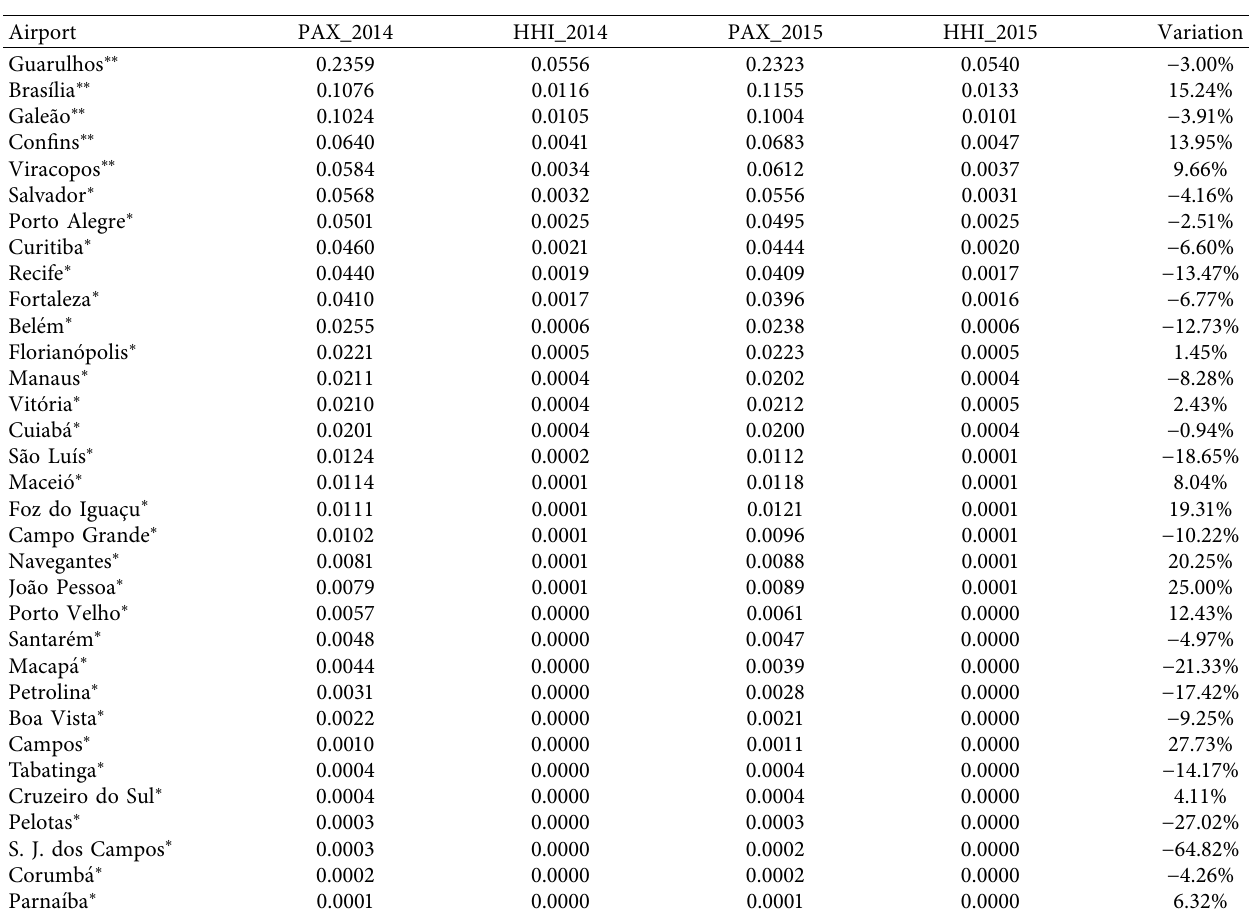
Table 11: Hirschman–Herfindahl